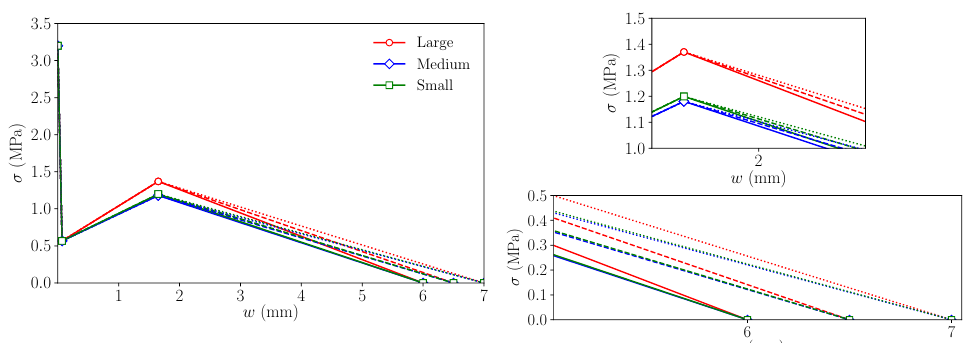
Figure 11. Left: trilinear diagrams used to study the influence of w f on the numerical simulations; upper right: detail of the diagrams around point r ; lower right: detail of the diagrams around point f (see Figure 3). Continuous lines represent the trilinear functions with w f = 6.0, dashed lines, the functions with w f = 6.5, and dotted lines, the function with w f = 7.0.